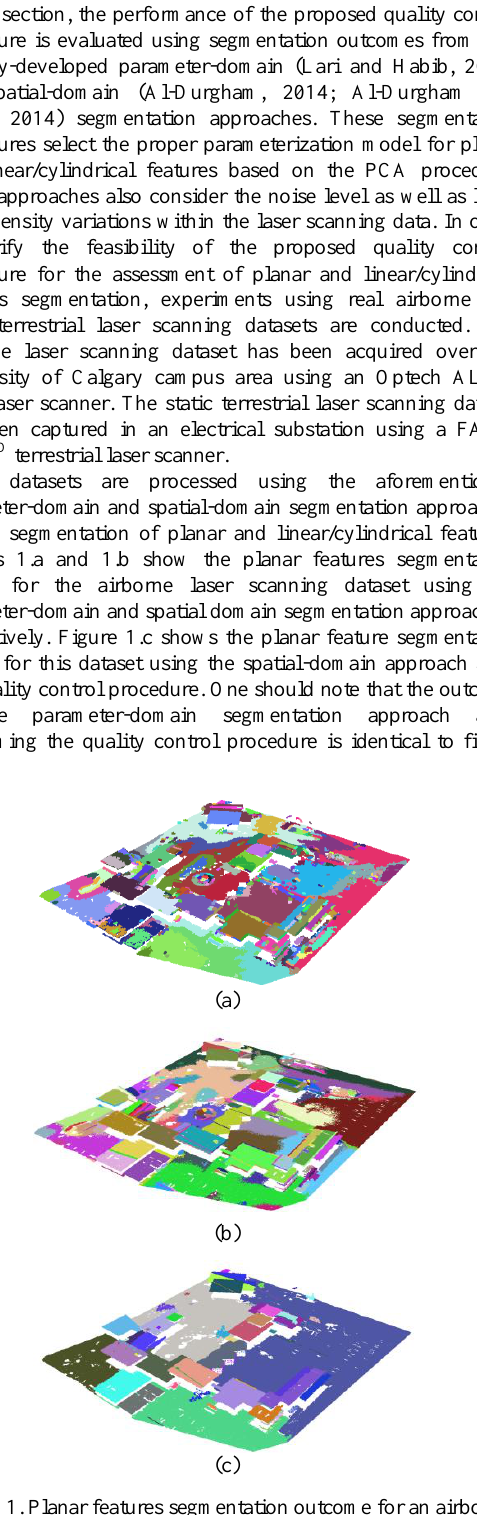
Figure 1. Planar features segmentation outcome for an airborne laser scanning data using (a) parameter-domain approach before the QC procedure, (b) spatial-domain approach before the QC procedure, and (c) spatial-domain approach after the QC procedure